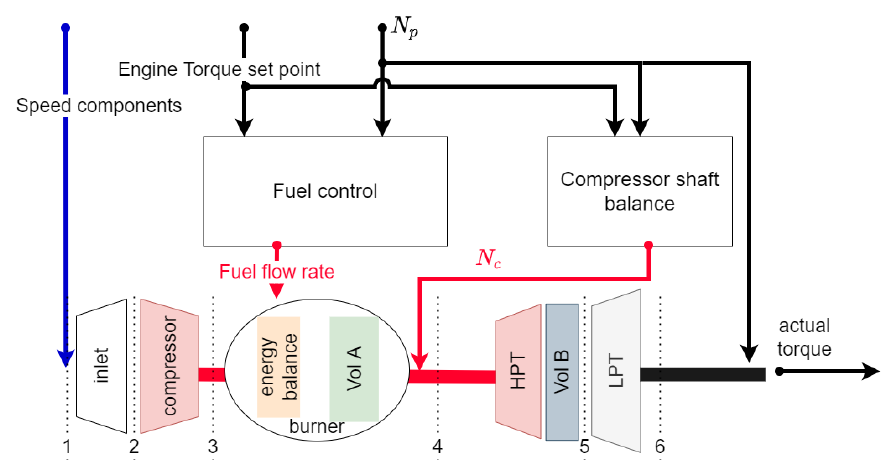
Figure 4. Details of the turboshaft dynamic model.